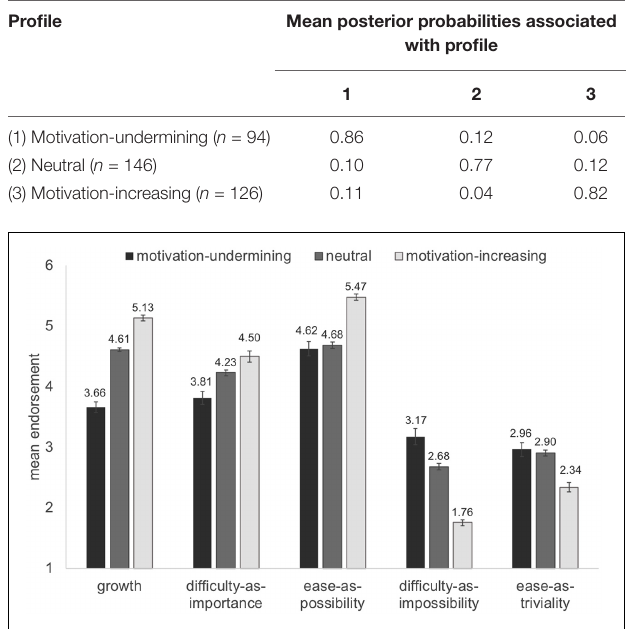
FIGURE 2 | Three latent profiles of implicit beliefs. Error bars represent standard error of the